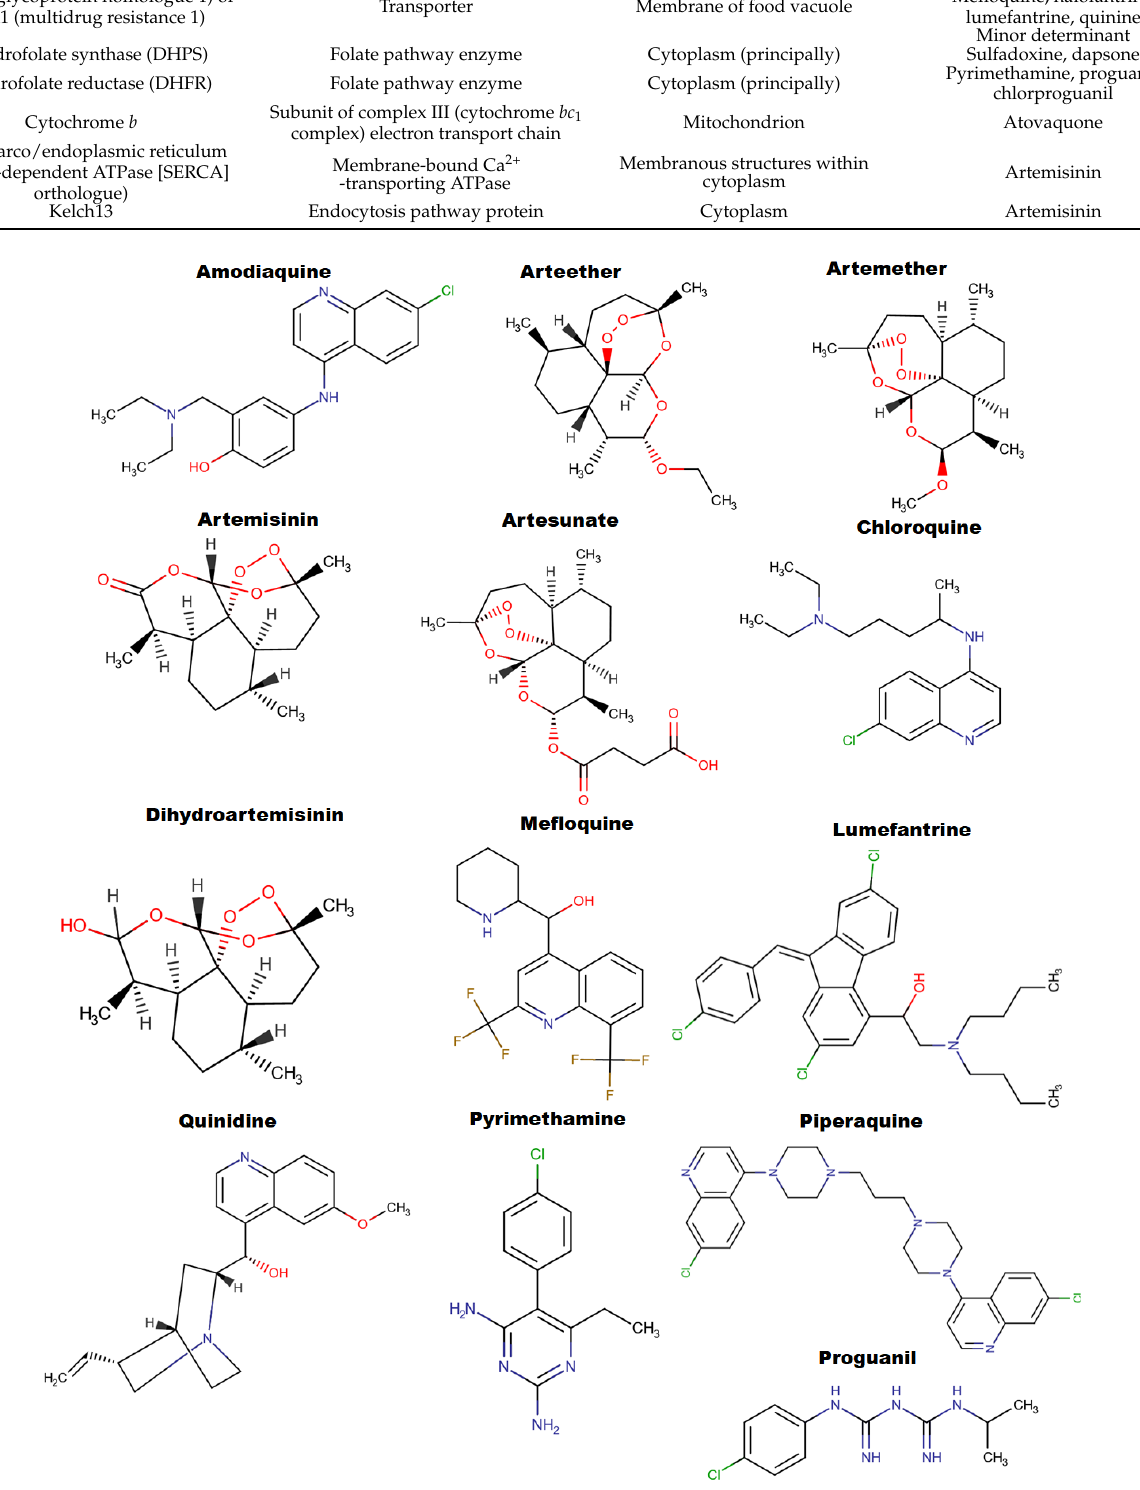
Figure 2. Chemical structural representation of frontline antimalaria drugs in clinical usage.